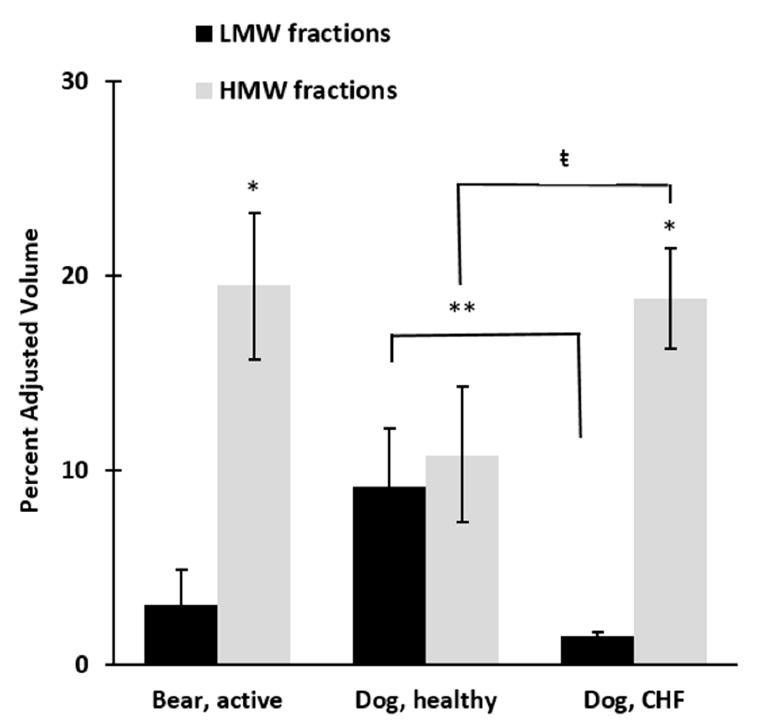
Figure 4. Pooled LMW and HMW fractions of myocardial adiponectin protein in six active bears, six healthy dogs, and six dogs with congestive heart failure (CHF). Fractions 3–6 contain the LMW isoforms of adiponectin and fractions 9–12 contain the HMW isoforms. Bears expressed 6.3 times greater concentration of HMW isoforms relative to LMW isoforms in both active period and hibernation. Healthy dogs expressed similar amounts of adiponectin isoforms, but dogs with CHF expressed 12 times greater concentrations of the HMW isoforms. * p < 0.0001; ** p = 0.005; ŧ p < 0.001.